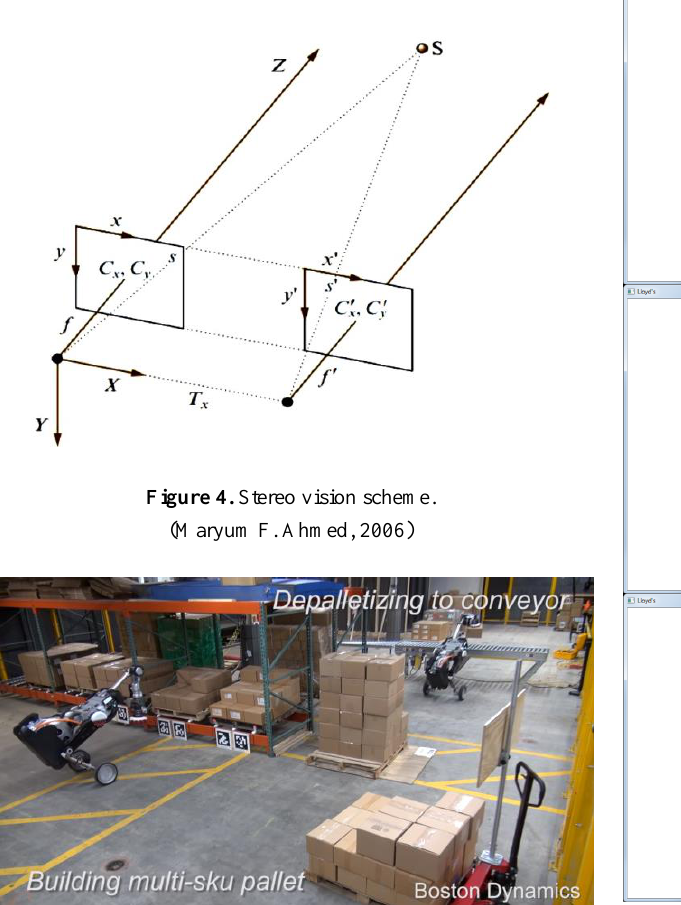
Figure 5. A robotic device manufactured by Boston Dynamics that sorts cargo in a warehouse.